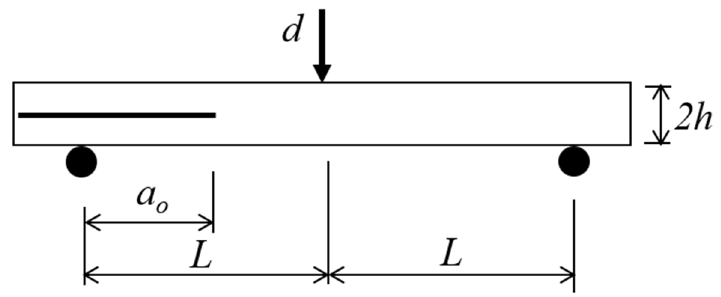
Figure 2. Schematic diagram of ENF test setup.